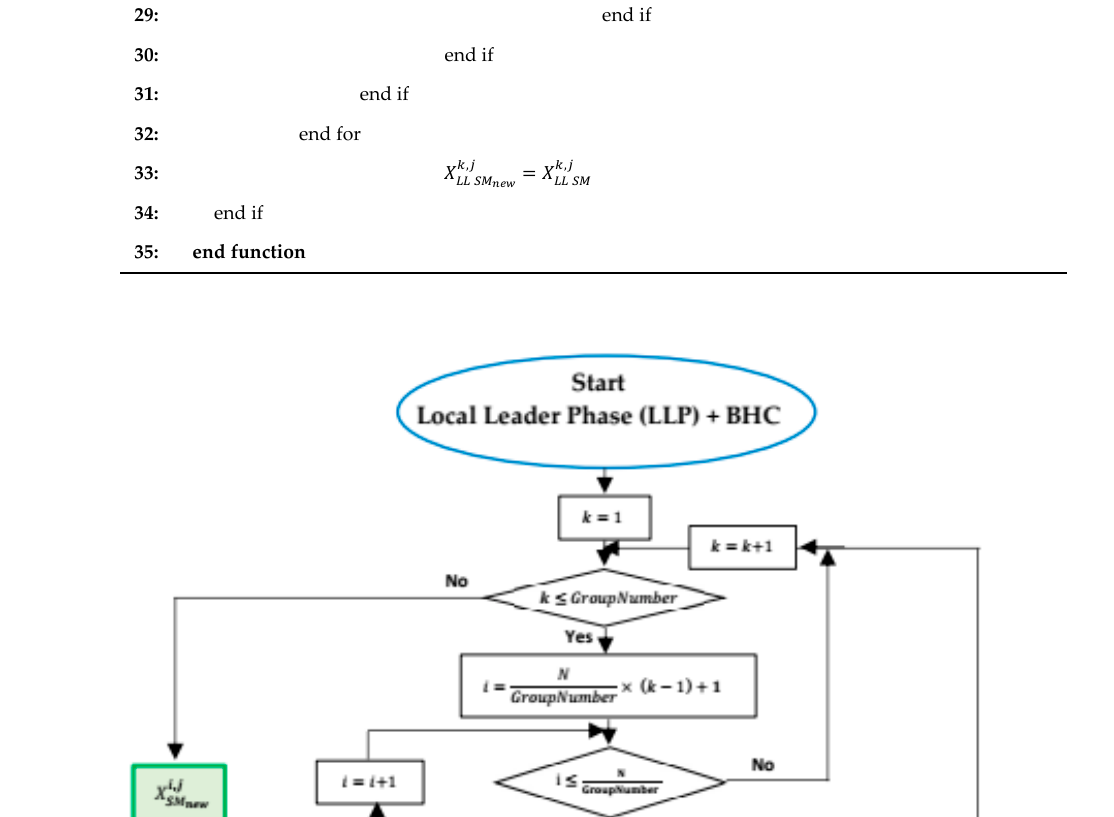
Figure 3. Flowchart of the Local Leader Phase (LLP) based on BHC.